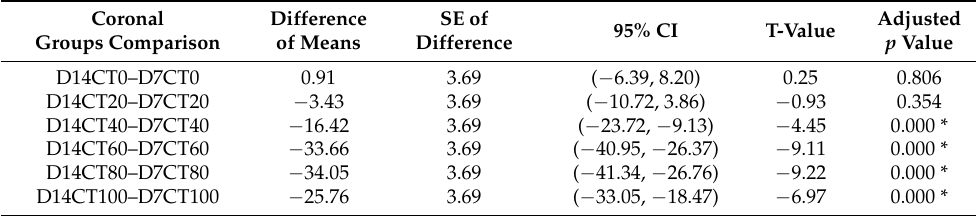
Table 4. Fisher test for 14 mm vs. 7 mm in the coronal area. * p < 0.05.